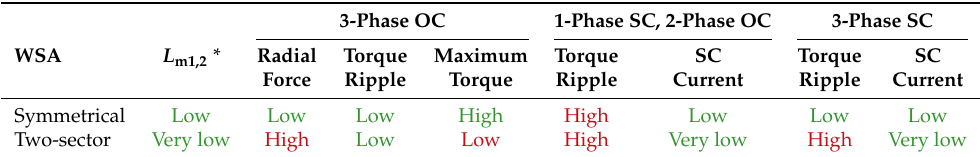
Table 11. Comparison of stator configurations for six-phase 12-slot 10-pole PMSMs for tolerating stator SCs (using FSCWs)